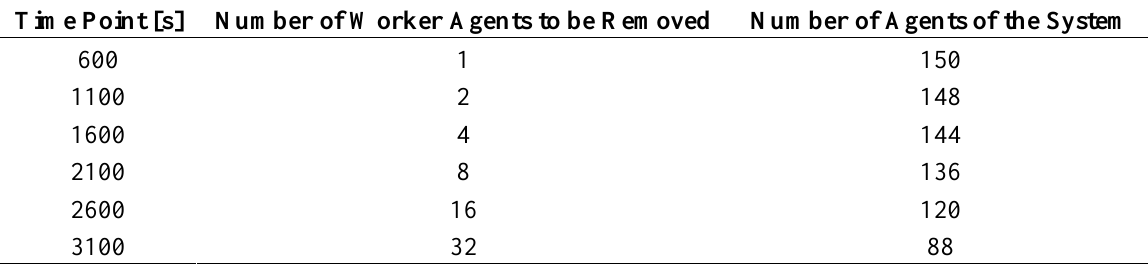
Table 1. Setting of changes in the test bed